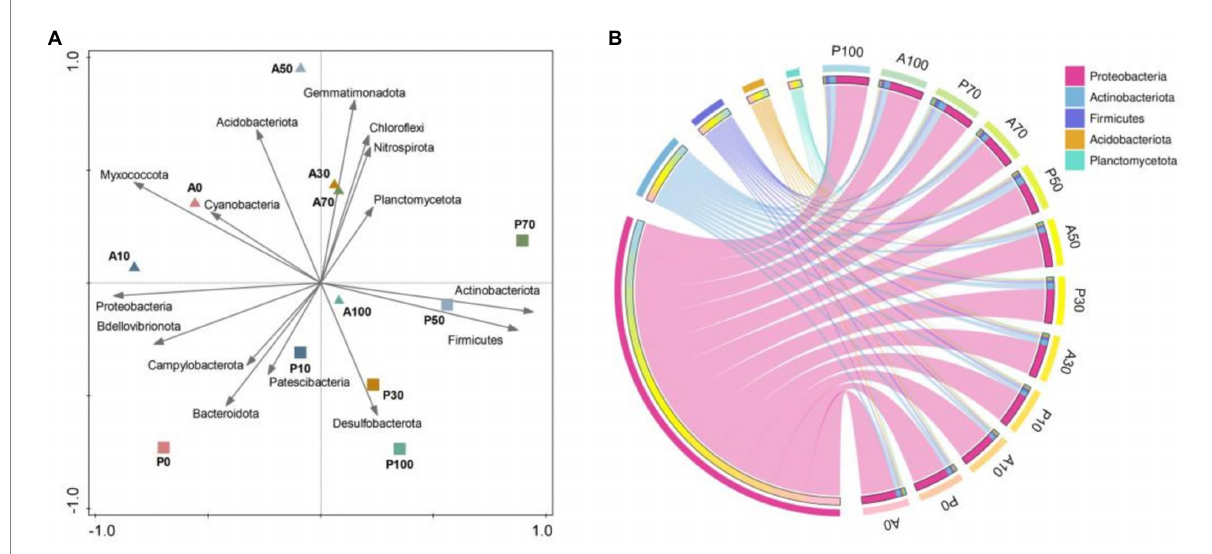
FIGURE 6 Effects of the different treatments on the soil bacterial community structure. Principal component analysis (PCA) based on the top 15 phylum of each sample (A) ; Chord diagram based on relative abundances of bacterial phylum in different treatments (B) . A0: Equivalent amount of methanol were added into native soil. A10: 10 mg kg − 1 atrazine-contaminated soil; A30: 30 mg kg − 1 atrazine-contaminated soil; A50: 50 mg kg − 1 atrazine- contaminated soil; A70: 70 mg kg − 1 atrazine-contaminated soil; A100: 100 mg kg − 1 atrazine-contaminated soil; P0: Equivalent amount of methanol and P. ureafaciens ZY were added into native soil; P10: 10 mg kg − 1 atrazine-contaminated soil with P. ureafaciens ZY inoculation; P30: 30 mg kg − 1 atrazine-contaminated soil with P. ureafaciens ZY inoculation; P50: 50 mg kg − 1 atrazine-contaminated soil with P. ureafaciens ZY inoculation; P70: 70 mg kg − 1 atrazine-contaminated soil with P. ureafaciens ZY inoculation; P100: 100 mg kg − 1 atrazine-contaminated soil with P. ureafaciens ZY